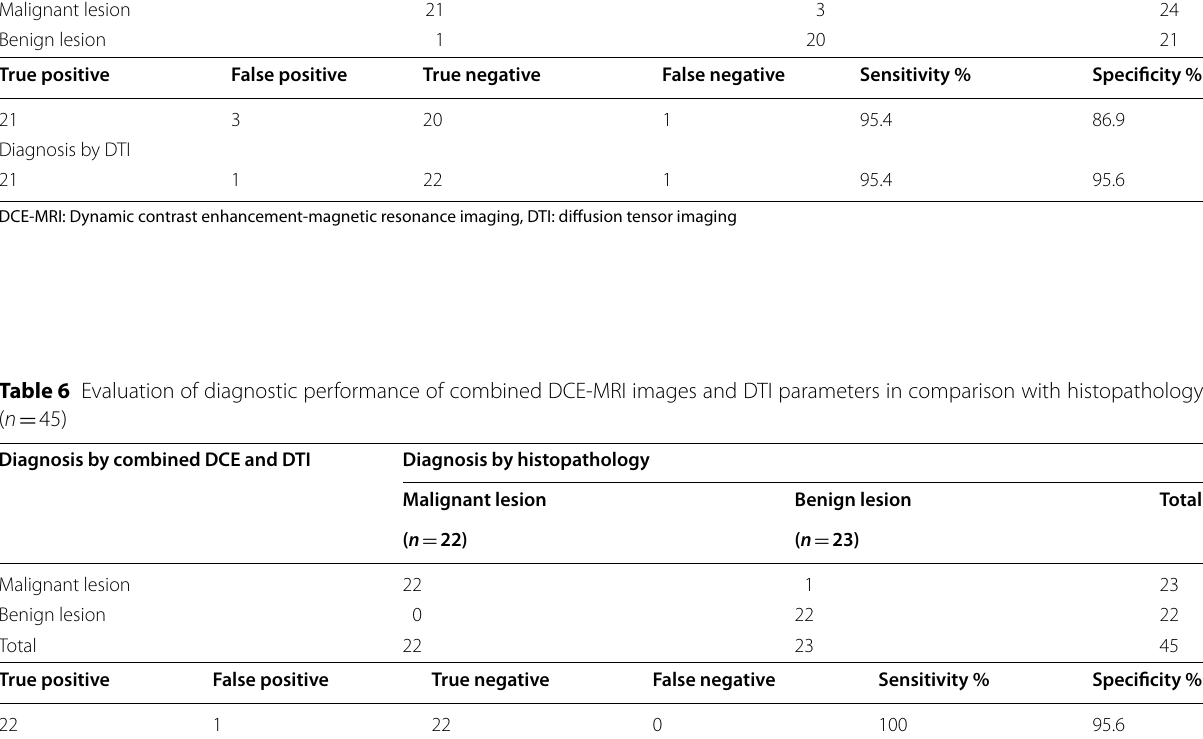
Malignant lesion 21